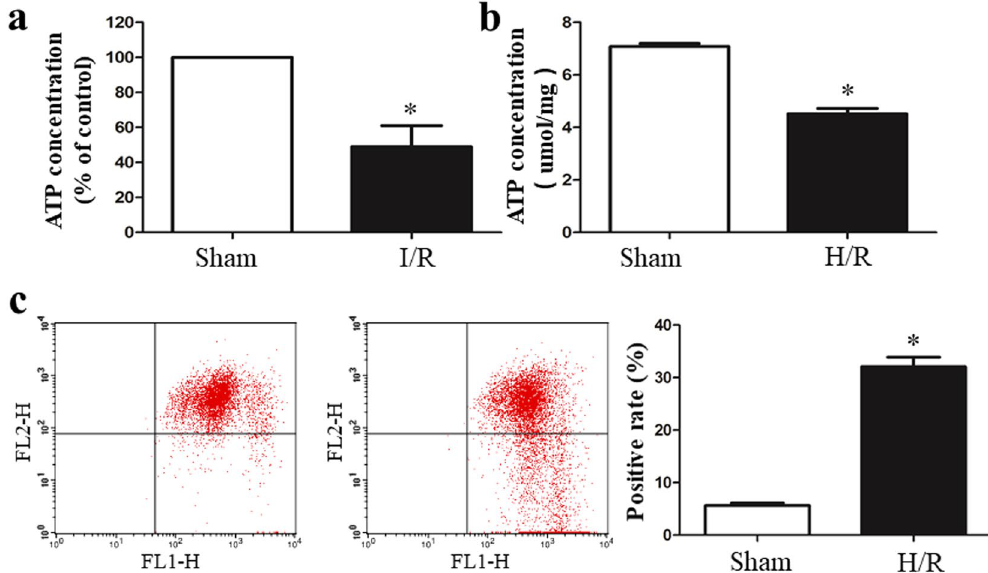
Figure 7. I/R caused mitochondrial dysfunction. The ATP concentration was quantified using a commercially available kit. ( a ) The ATP concentrations were significantly decreased in the I/R group in vivo . ( b ) H/R decreased the ATP levels compared with those in the control group. ( c ) The H/R-treated IEC-6 cells showed a decrease in the mitochondrial membrane potential ( ΔΨ m). The data are expressed as means ± SD. * P < 0.05 vs the sham group or H/R group.